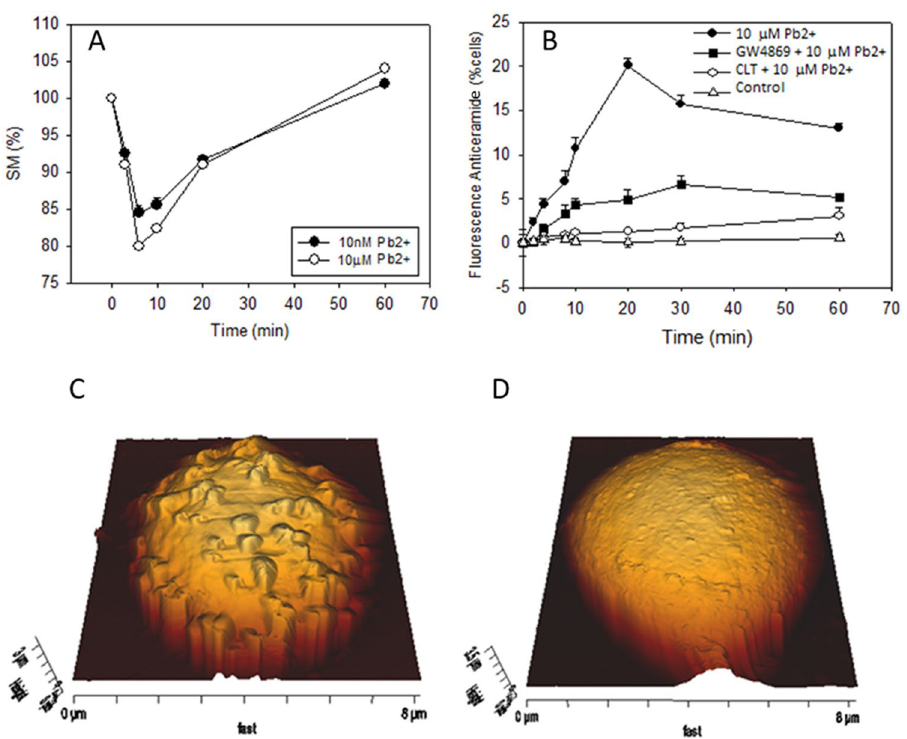
Figure 6. Quantitation of sphingomyelin ( A ) and ceramide ( B ) over time during Pb(II) incubation. Average of three measurements ± S.E.M. (In some cases the error bars are smaller than the symbol). Representative AFM images of GW4869-treated RBC after 15 h Pb(II) exposure in the absence of lysis ( C , D ). For experiments in A, SM was quantified using TLC 39 . For the experiments in B, FACS was